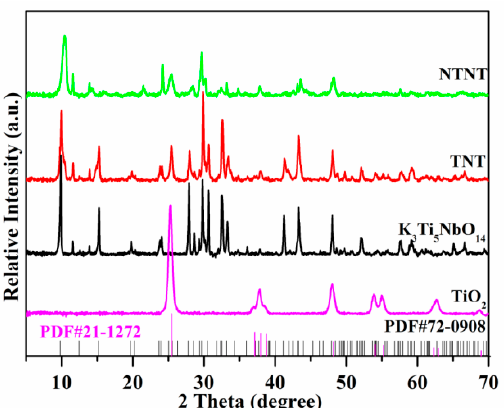
Figure 1. XRD patterns of N-doped K 3 Ti 5 NbO 14 @TiO 2 (NTNT), TNT, K 3 Ti 5 NbO 14 , TiO 2 , and the standard patterns of K 3 Ti 5 NbO 14 (JCPDF: No. 72-0908) and TiO 2 (JCPDF: No. 21-1272).